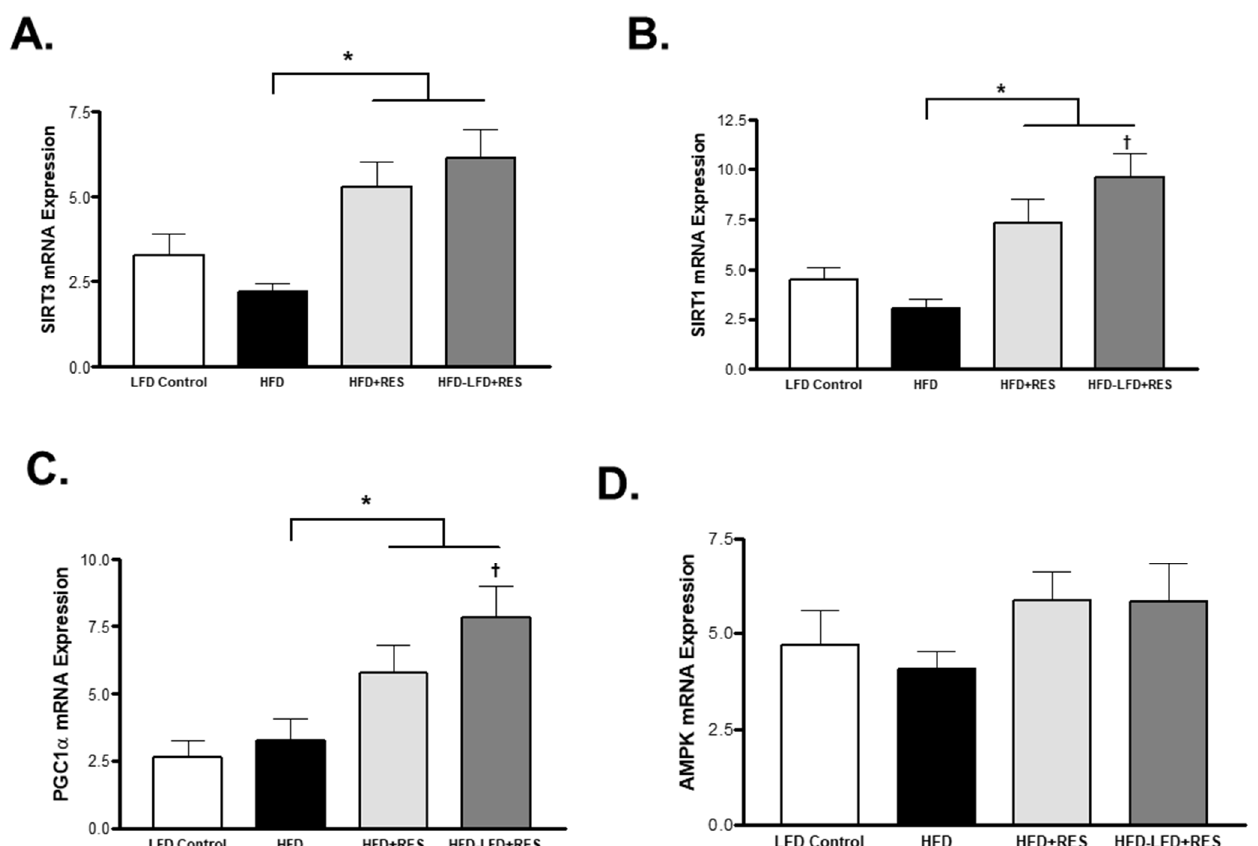
Figure 2. mRNA expression levels of sirtuins and oxidative capacity genes in Gastrocnemius muscle. ( A ): SIRT3 mRNA expression. ( B ): SIRT1 mRNA expression. ( C ): PGC1 α mRNA expression. ( D ): AMPK mRNA expression. * p < 0.05 vs. HFD; † p < 0.05 vs. HFD+RES. Values represents mean ± S.E.M. ( n = 6–8).